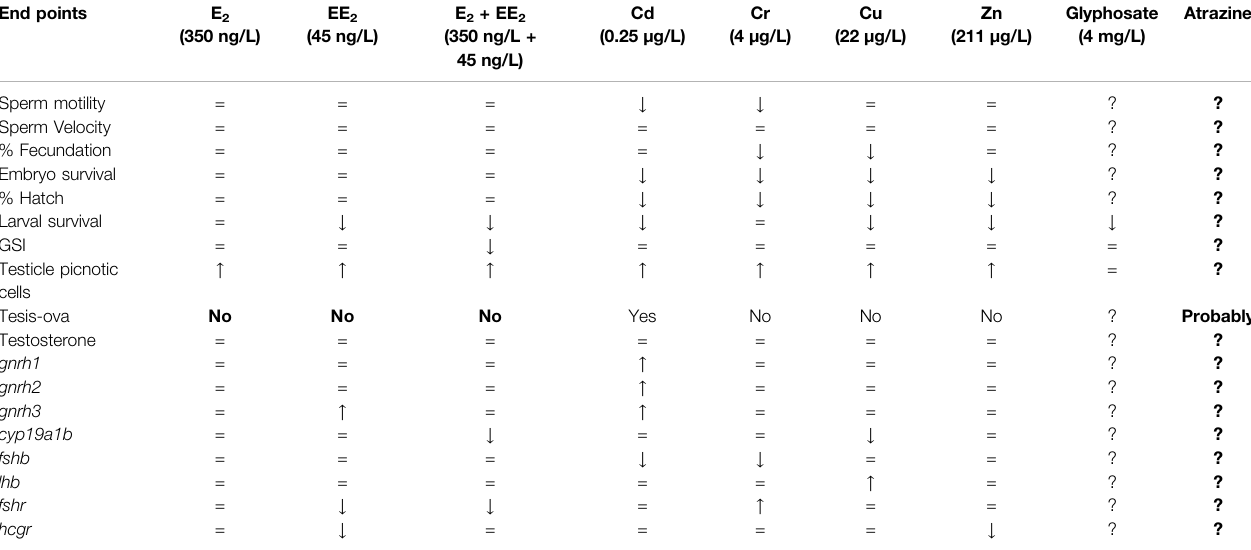
TABLE 1 | Effects of environmental concentrations of different pollutants identi fi ed in Pampas lakes on development and reproduction of pejerrey O. bonariensis. End